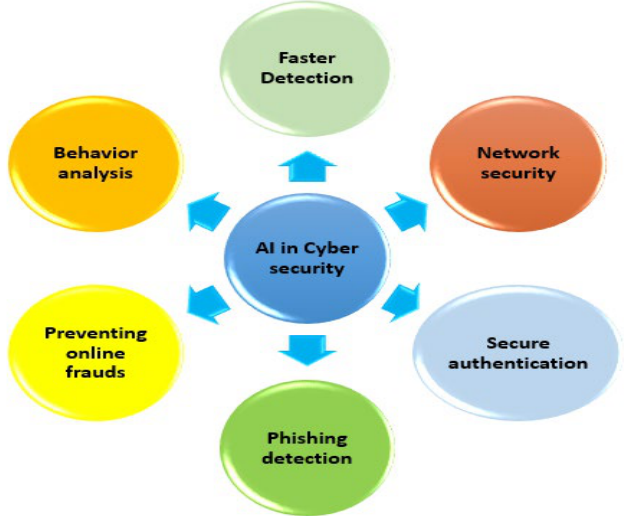
Figure 5. AI in Cybersecurity [40].